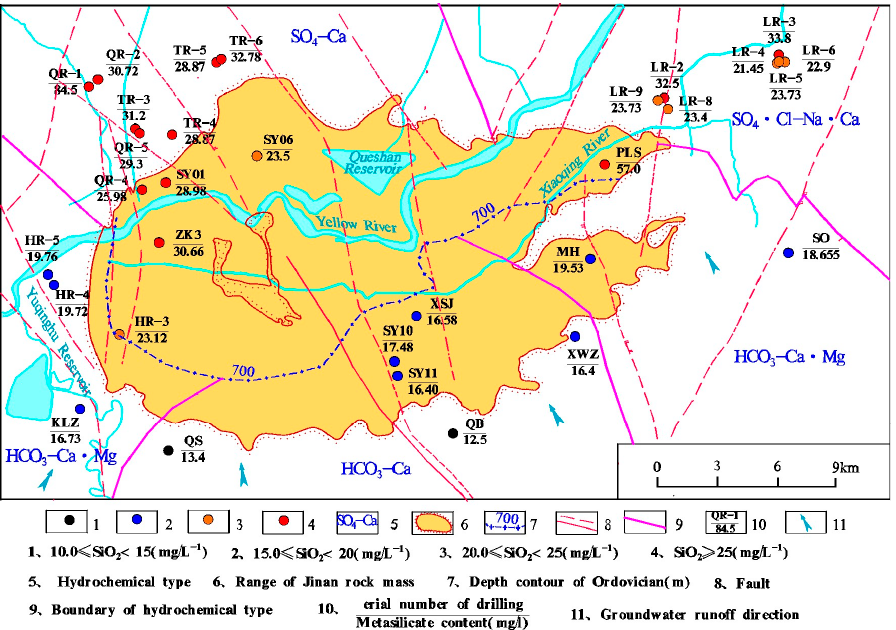
Figure 2. The metasilicate content, hydrochemical types, and distribution of the groundwater in the study area (The content of H 2 SiO 3 is the concentration unit mg·L − 1 ).